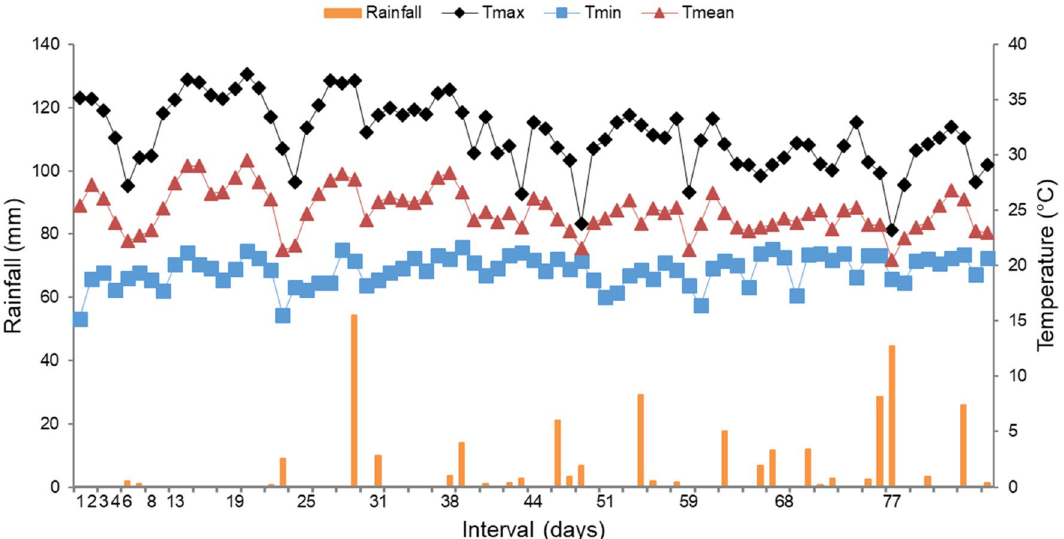
Figure 4. Daily rainfall and daily minimum (Tmin), daily mean (Tmean) and daily maximum (Tmax) ambient temperature throughout the